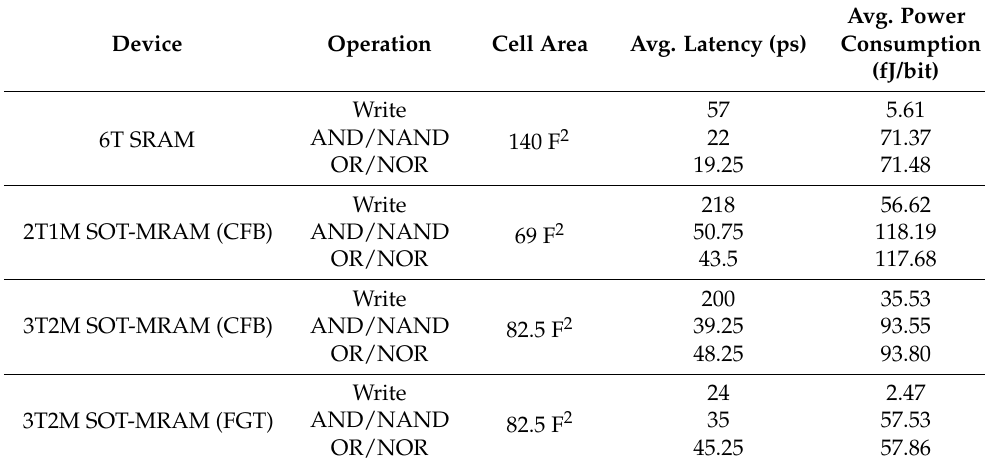
Table 3. Benchmark and comparison of the performance among different storage